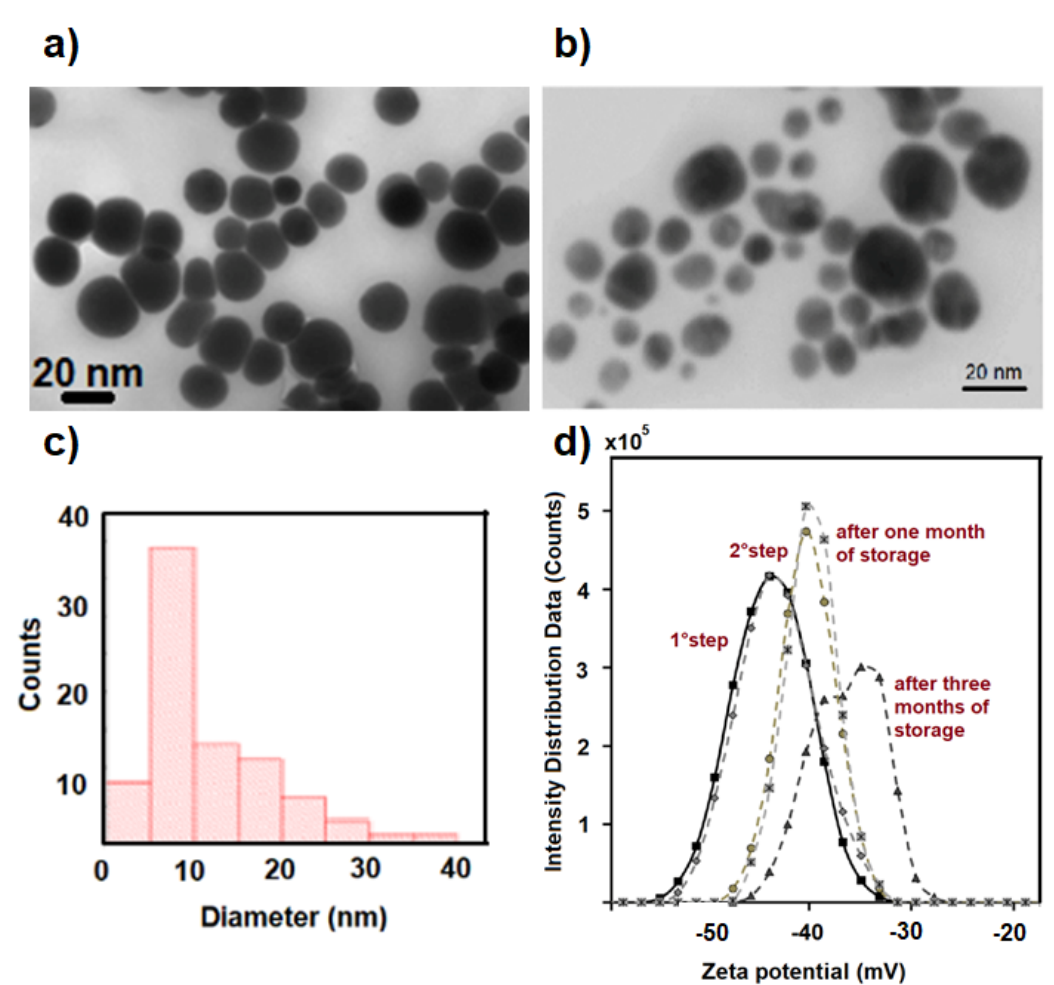
Figure 2. UV-vis optical absorbance spectra at different times during the first ( a – c ) and second ( d ) step of UV irradiation treatment to prepare Ag-PMA nanocolloid. The spectrum after one month by the second step of irradiation is also shown ( d ). The optical absorbance value vs. time is reported in panel ( e ) for the two main processes (NPs nucleation and aggregates).